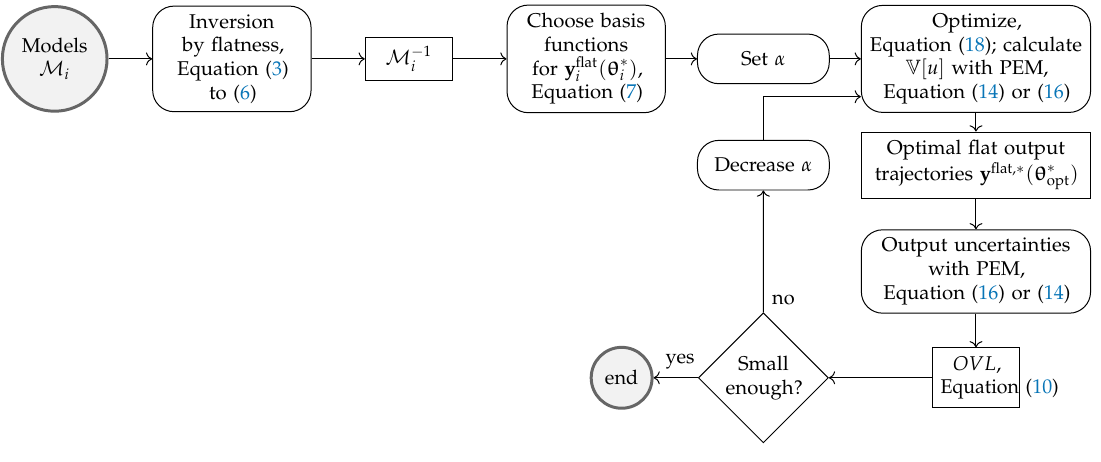
Figure 3. Robust MBDoE